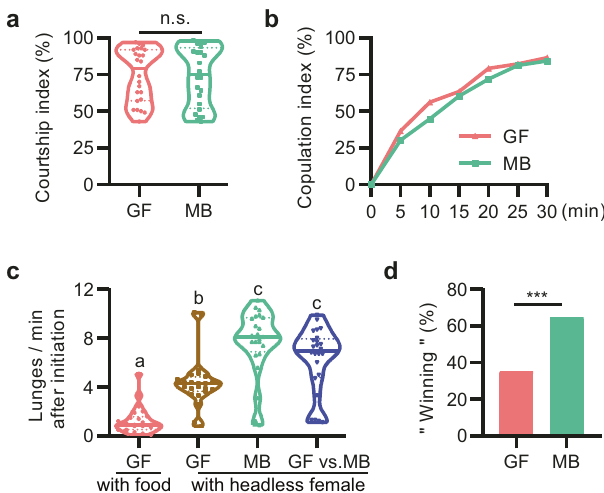
Fig. 3 Germ-free males have normal courtship but are less competitive. a , b GF males did not exhibit a signi fi cant difference in courtship index ( a ) or copulation index ( b ) compared to MB ones. Conventionally reared wild- type virgin females were used as targets. n = 24 for courtship, n = 96